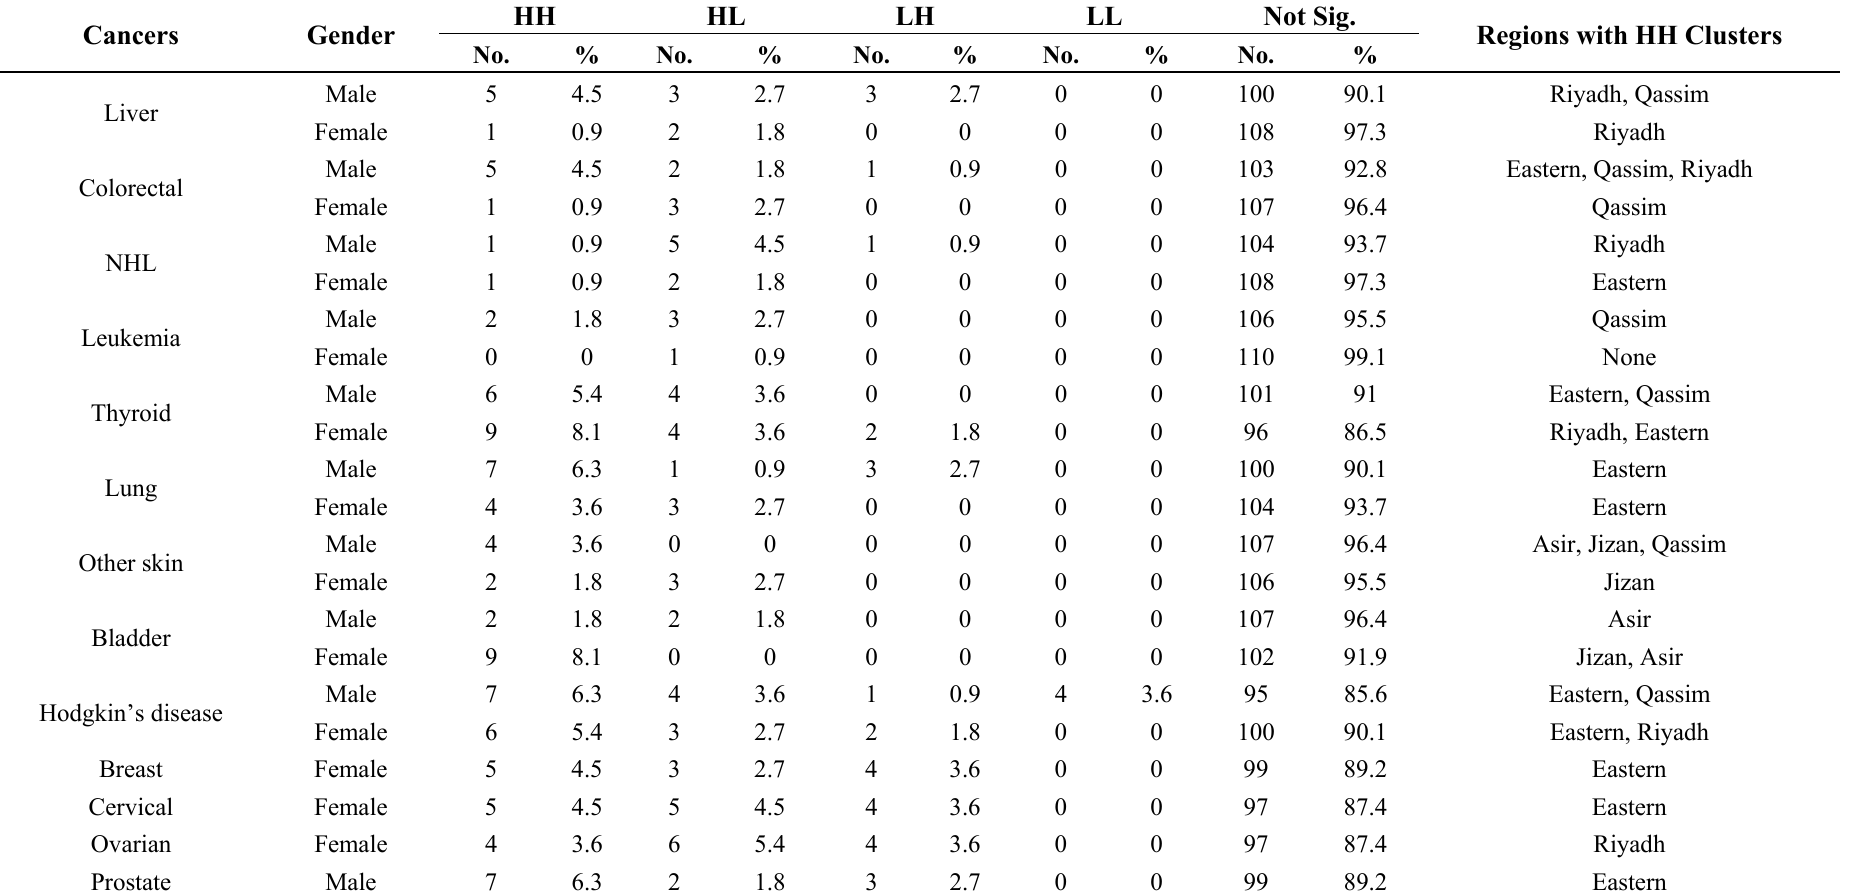
Table 2. Anselin local Moran’s I (ALMI) statistic